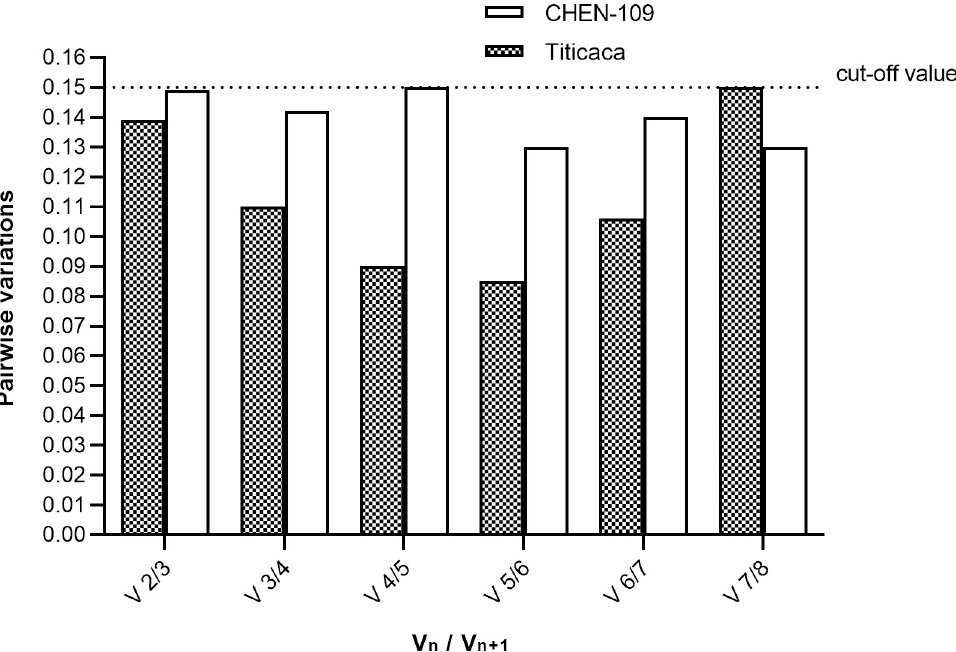
Fig 4. Pairwise variation analysis of the candidate genes. The analysis was performed by geNorm for determination of the appropriate number of reference genes. Below 0.15 (default cut-off value) all gene pairs were considered stable and the addition of a third gene for normalization is not required. V n is the pairwise variation of a given number of reference genes and V n+1 is the pairwise variation produced when an extra reference gene is added to the